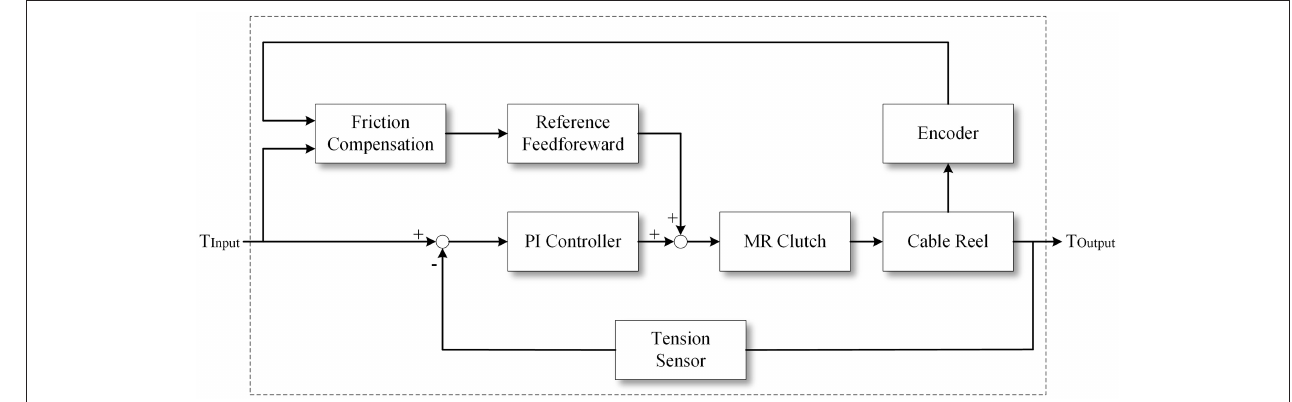
FIGURE 6 | The MR-Cable tension control block diagram.